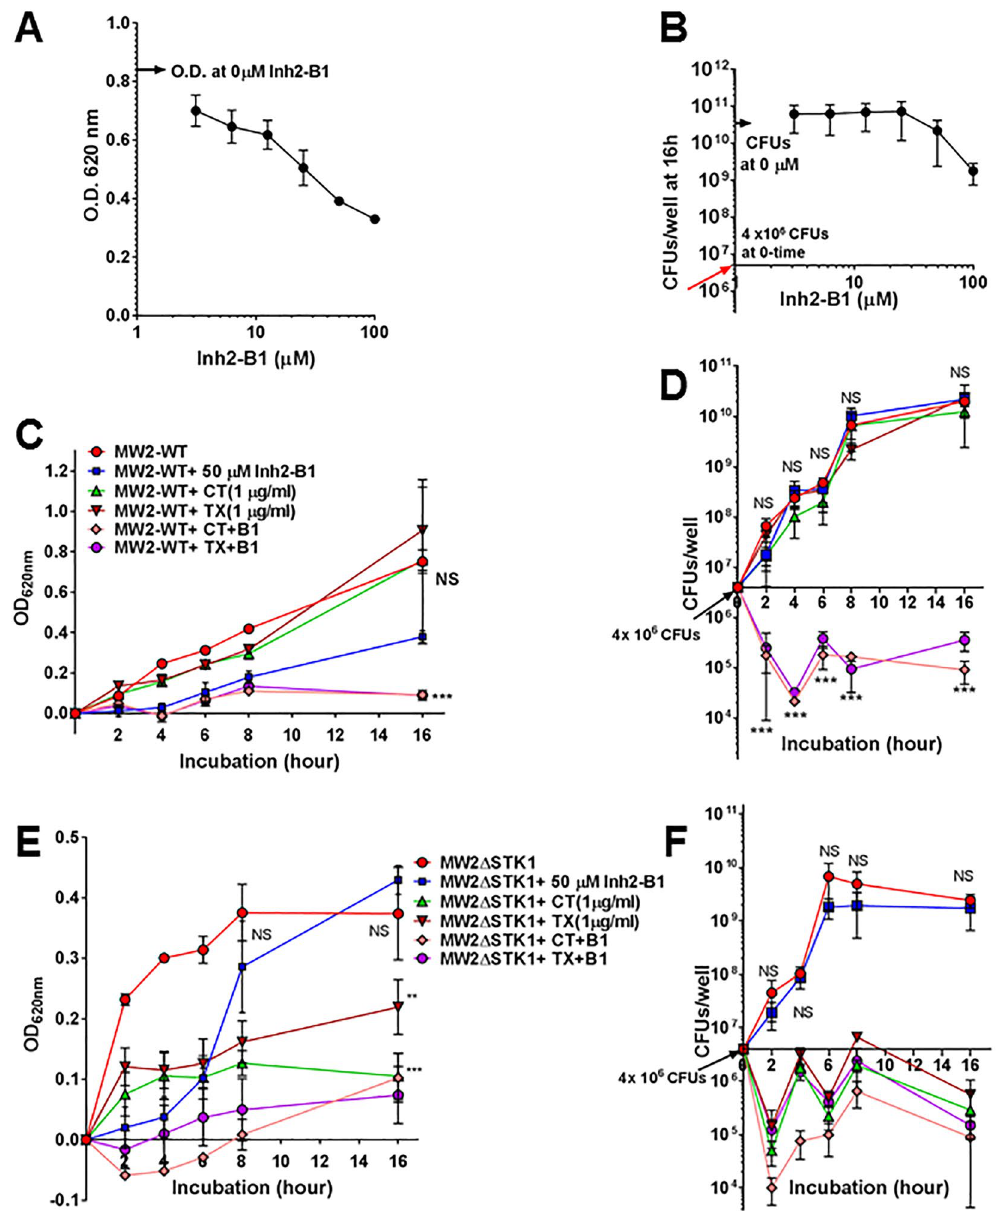
Figure 4. Effects of Inh2-B1 enhances the bactericidal activity of Ceftriaxone and Cefotaxime. Time-to-kill experiment shows Optical Density (OD) at 620 nm and viable bacterial counts (colony forming units) of ( A , B ) MW2-WT at different time intervals, when grown in the presence and absence of Inh2-B1 inhibitor. Optical Density and corresponding Colony forming units of ( C , D ) MW2-WT and ( E , F ) MW2 Δ STK1 cultures in the presence or absence 50 µ M Inh2-B1, 1.51 µ M (1 µ g/ml) Ceftriaxone, 2.125 µ M (1 µ g/ml) Cefotaxime, and combination of Inh2-B1 plus Ceftriaxone, and Inh2-B1 plus Cefotaxime. The experiments were carried out as described in the Materials and Method section using Muller-Hinton broth and seeded with 4 × 10 6 CFUs of S . aureus MW2-Wild type or MW2 Δ STK1 strains per well. Each data points represent Mean ± S.D. P values of significance ( ** < 0.01, *** < 0.001) were determined using the t -test with Welch’s corrections. NS-Not